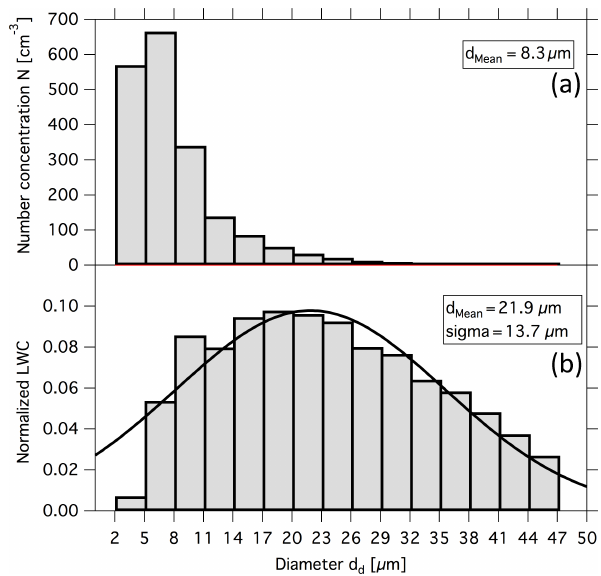
Figure 1. Droplet number (a) and mass distribution (b) of the su- percooled cloud generated in the wind tunnel. The average error due to count statistics for the given distributions is